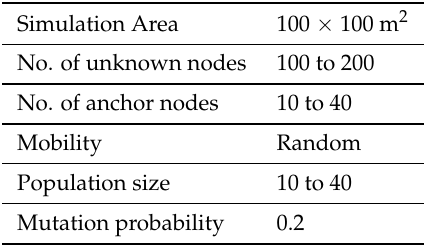
Table 2. Simulation